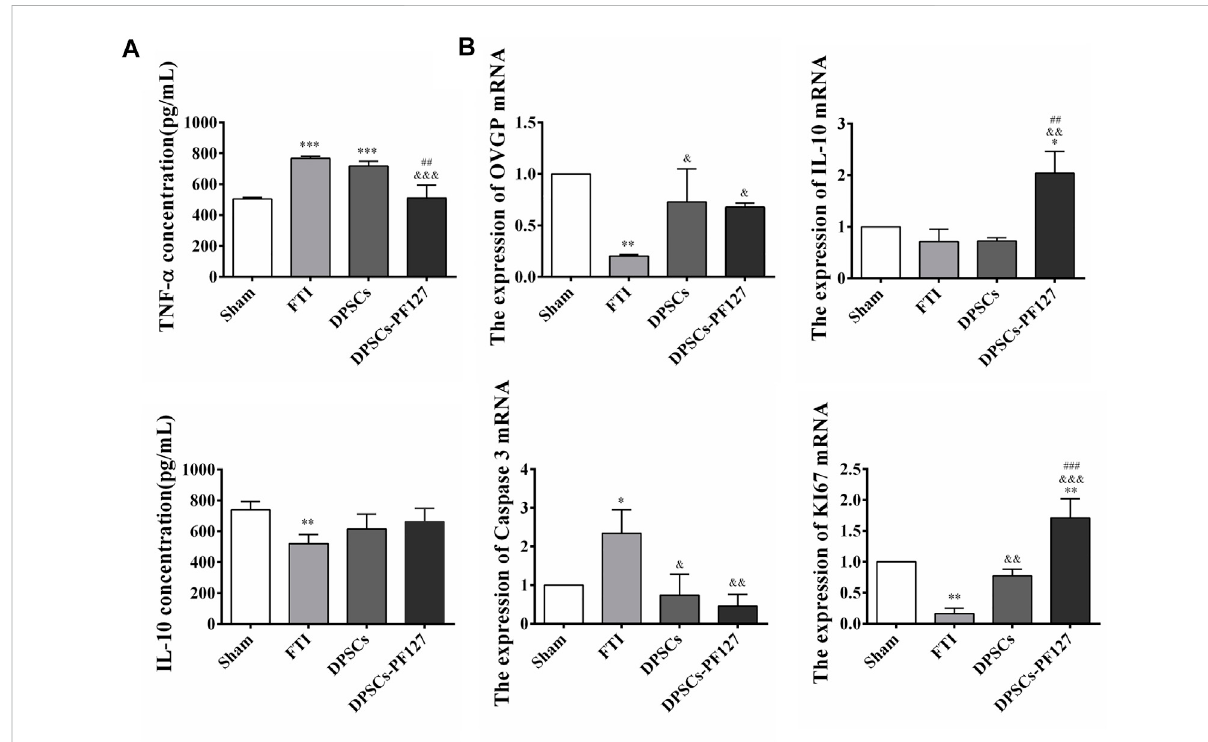
FIGURE 10 Concentration of in fl ammatory factors in serum and mRNA detection of the FT at 4 weeks after surgery. (A) Comparison of the serum TNF- α andIL-10concentrationamongthegroups.** p < .01,*** p < .001versustheShamgroup. &&& p < .001versustheFTIgroup. ## p < .01versustheDPSCs group. (B) The expression of OVGP, IL-10, Caspase 3, KI67 mRNA of the FT tissues among the groups. * p < .05,** p < .01 versus the Sham group. & p < .05, && p < .01, &&& p < .001 versus the FTI group. ## p < .01, ### p < .001 versus the DPSCs